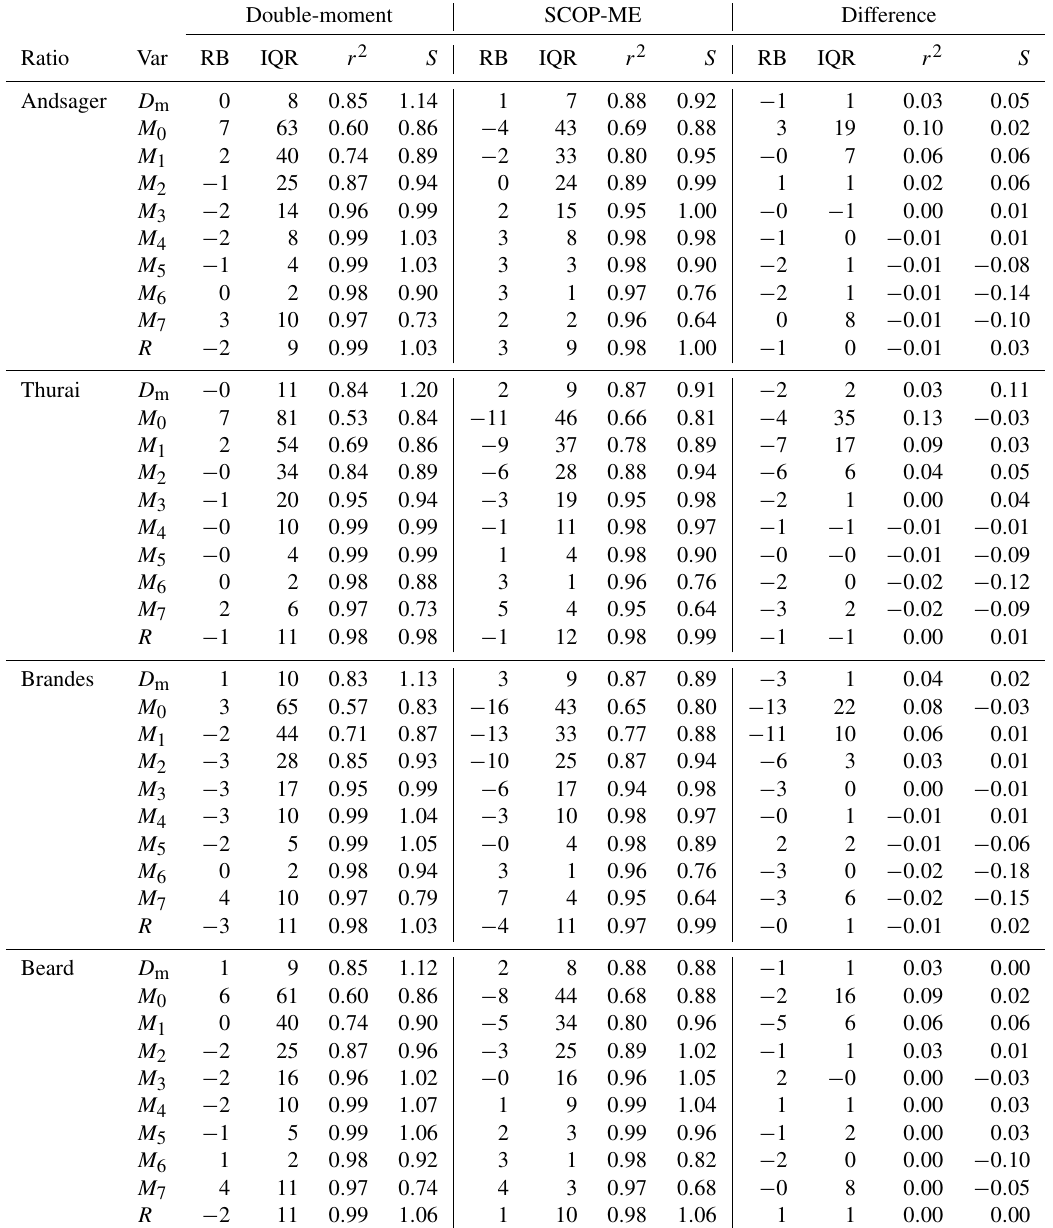
Table A2. Comparison of double-moment method to SCOP-ME results on all Parsivel data in the Payerne data set by axis ratio function (Ratio). Columns are as for Table